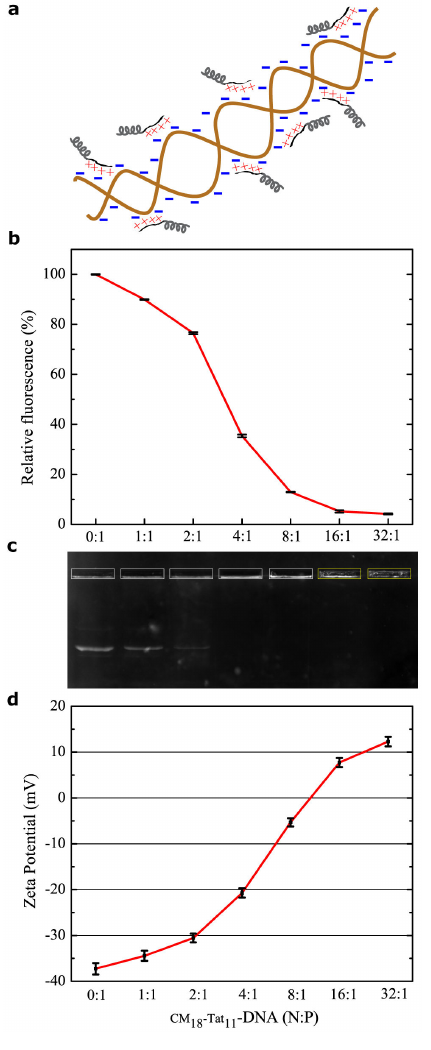
Figure 1. CM characterization. ( a ) Hypothetical ionic interaction model between DNA plasmid (brown fragment with blue negative charges) and CM with red positive charges). ( b ) CM